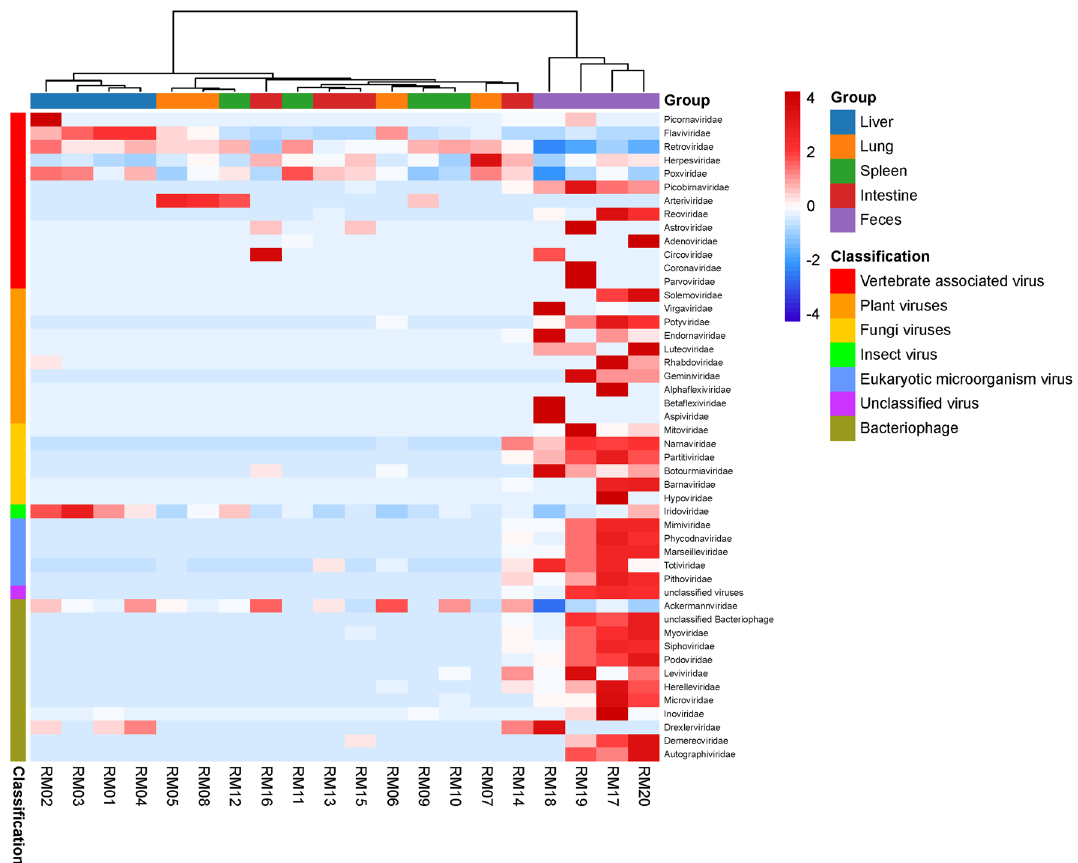
Figure 4. Heatmap based on the distance matrix calculated by the Euclidean distance method according to the normalized number of reads belonging to each viral family in 20 pools. X axis shows sample names, and the Y axis the names of viral families. Red to blue, highest to lowest abundance of viral reads according to viral family. The hierarchical clustering is based on the Euclidean distance matrix calculated from the normalized read